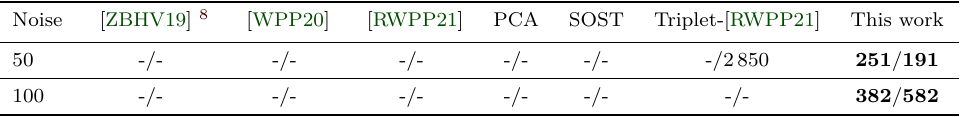
Table 6: Benchmark the attack performance ( T GE 0 ) with the ASCAD_F dataset perturbed with desynchronization. Attack results for the HW and ID leakage models are separated by ’/’.